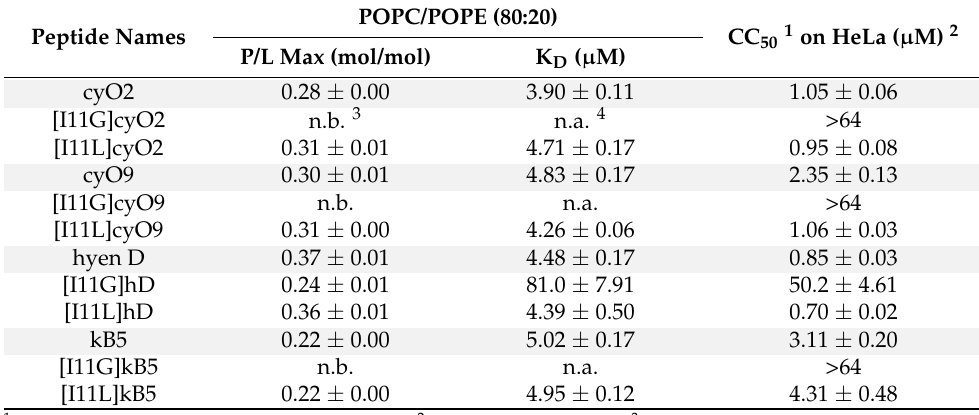
Table 2. Cytotoxicity and membrane-binding properties of bracelet cyclotides and their mutants